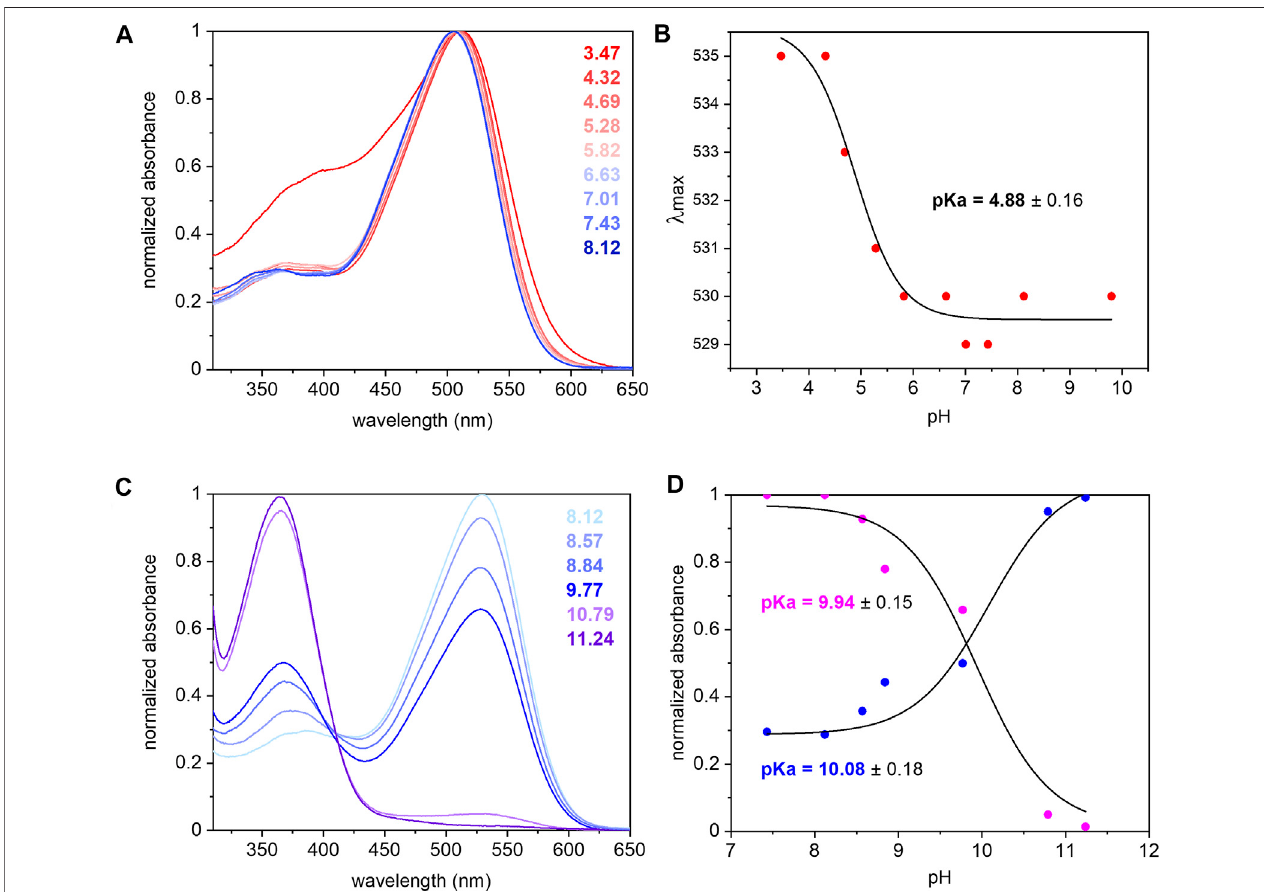
FIGURE2| UV/Visspectraof Um Rh1atdifferentpHsandretinalextraction. Um Rh1wasdissolvedinanaqueoussolutionof100 mMNaCl,10 mMcitrate,10 mM MES,10 mM HEPES, 10 mMMOPS,10 mM glycine,0.03% DDM,and titrated byaddition ofsmallvolumes of1 NNaOHor HCl. (A) UV/Visspectrawererecorded ata starting pH of 8.12 and after stepwise addition of 1 N HCl to reduce the pH. (B) The maximal absorption of Um Rh1 is plotted against pHs and fi tted to the Henderson- Hasselbalch equation to derive the pKa of the color transition as described (Inoue et al., 2018). The equation λ max (cid:1) υ / ( 1 + 10 ∧ ( pH − pKa )) + ω is applied, v represent the maximum λ max , ω is the offset. (C) UV/Vis spectra of Um Rh1 in the alkaline range of pH 8.12 – 11.24. (D) The pKa estimation in alkaline range is done by fi ttingthenormalizedabsorbanceatboth530(magenta)and365(blue)nmindifferentpHsasdescribedin (A,C). Fortheaccumulationofblue-shiftedstate(365 nm),the equation A (cid:1) υ / ( 1 + 10 ∧ ( pKa − pH )) + ω is